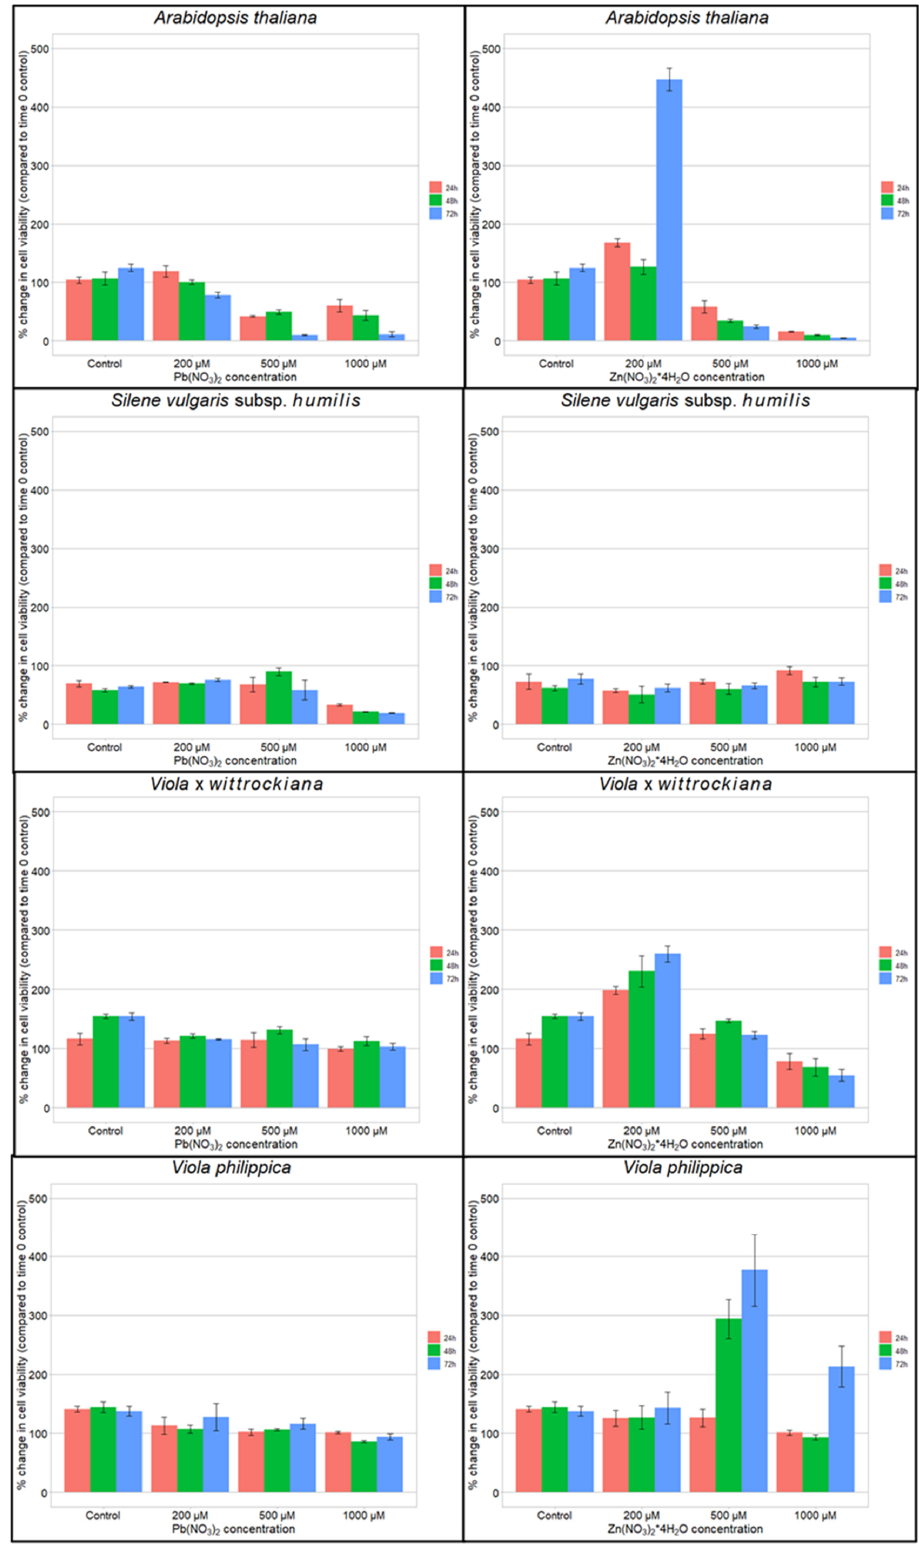
Figure 2. The mean frequency (+/ − SD) of viable cells after treatment with different concentrations of Pb and Zn. Means and standard deviations were established based on altogether N = 9 measurements. Frequency of viable cells of V. tricolor (metallicolous population) after treatments could be found in Sychta et al., 2018